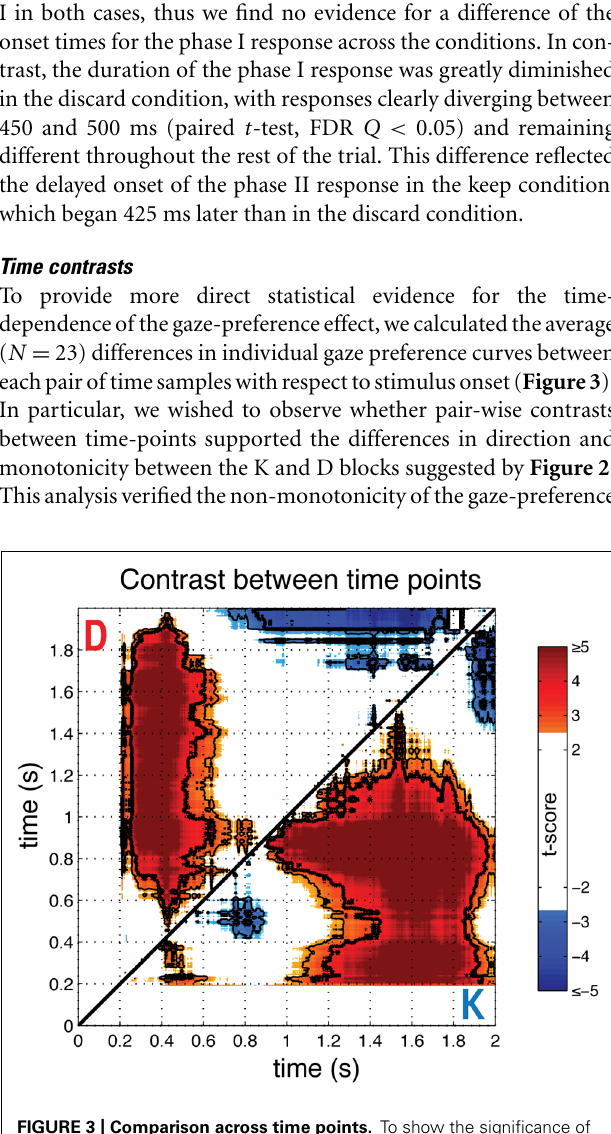
FIGURE 3 | Comparison across time points. To show the significance of non-monotonicity in block K and the differences in the bias towards the response-compatible item across blocks, the pairwise difference between time points for individual gaze-preference curves was computed and averaged across individuals ( N = 23), shown as a t -score. Results for the keep condition are below the diagonal (K), and discard condition above (D). Plots are thresholded at FDR corrected significance of Q < 0.1 and significance levels of Q < 0.05 and Q < 0.01 are indicated, respectively, with thin and thick contour lines. Each point represents a t-score for the paired difference between the gaze-preference effect at the time indicated at the abscissa minus the effect at the time indicated at the ordinate, with respect to stimulus